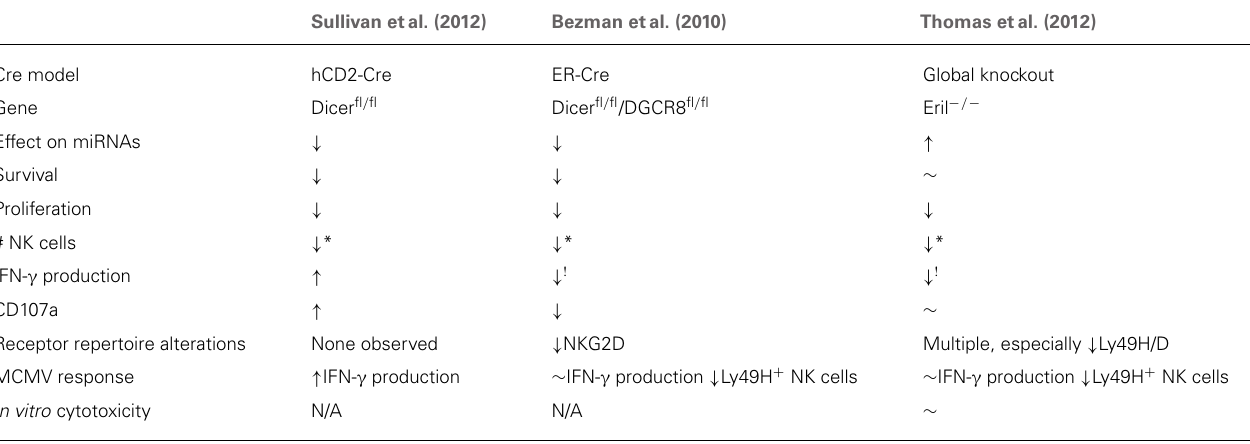
Table 2 | Summary of global miRNA-deficient (Dicer1 − / − and DGCR8 − / − ) or over-expression (Eri1 − / − ) NK cells. Sullivan etal. (2012) Bezman etal.